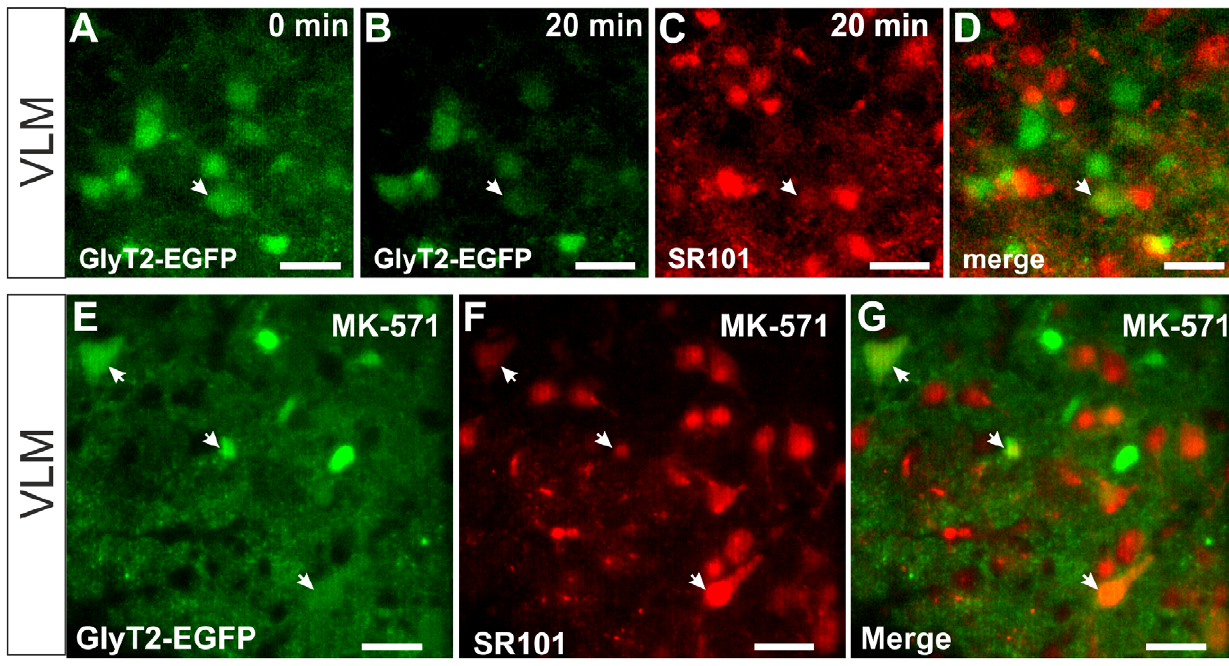
Figure 8. SR101 in neurons of the ventrolateral medulla. A–D: two-photon images from the SR101-labeling procedure of EGFP-labeled inhibitory neurons (GlyT2-EGFP) in the ventral-lateral medulla. A,B: Green EGFP-fluorescence is quickly photo-bleached during the 20 min SR101 application. C: At 20 min, SR101 is increasing in numerous cells, but SR101 could only be found in one EGFP-positive neuron (arrow). D: Overlay of panels A and C. E–G: SR101-labeling of GlyT2-EFGP neurons ( E ) and SR101-labeled cells ( F ) in the presence of MK-571 (200 m M). G: merged image from E and F. The arrows point to SR101-labeled glycinergic neurons. Scale bars: 40 m m.